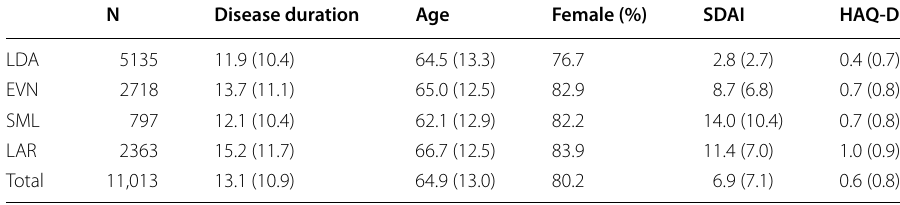
Data are shown as mean (SD) unless otherwise described SDAI Simplified Disease Activity Index, HAQ-DI the disability index of the Health Assessment Questionnaire, LDA low disease activity